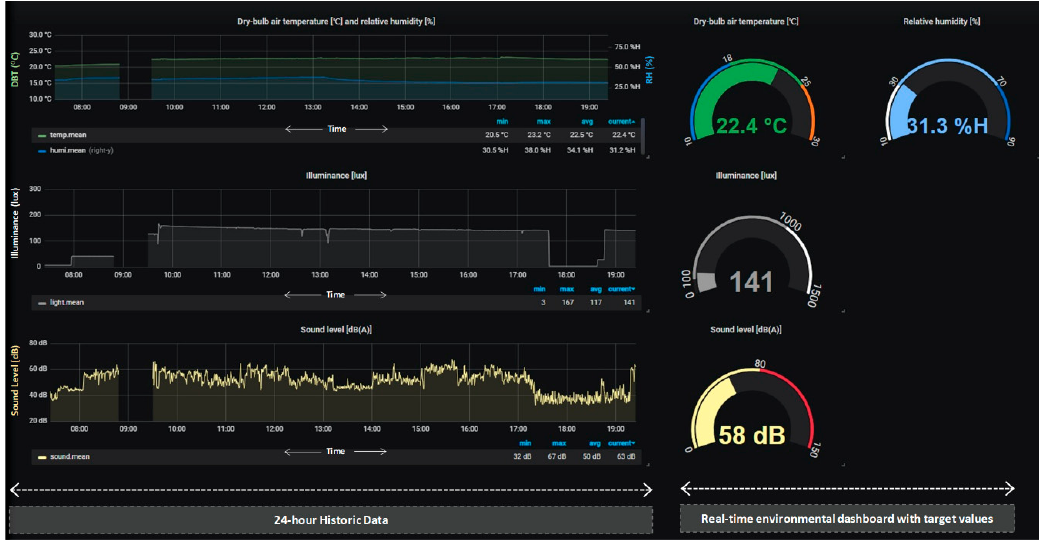
Figure 11. DBT, relative humidity (RH), Illuminance and Sound levels—Real-time IoT data visualisation in the Print Office (source: IoT data display in Grafana tool, edited by the author).